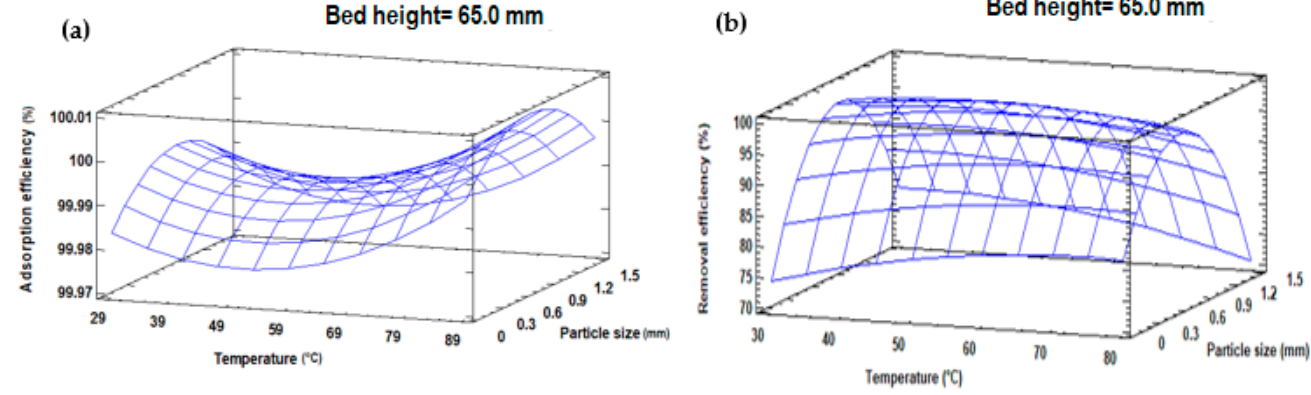
Figure 5. Estimated response area for the removal efficiency of ( a ) CrVI) and ( b ) Ni(II) on